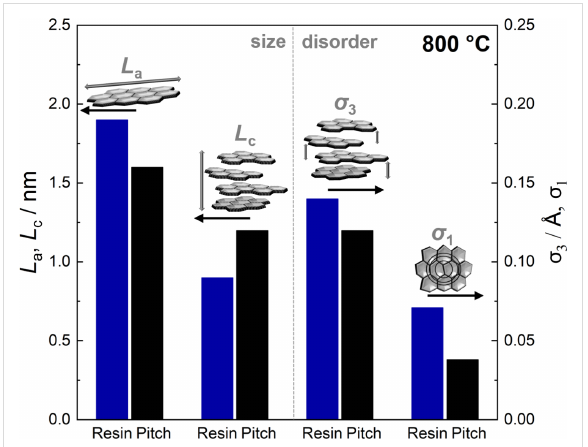
Figure 7: Microstructural parameters describing the size and disorder of graphene-like structures. The values are obtained from templated resin (blue) and pitch (black) carbonized at 800